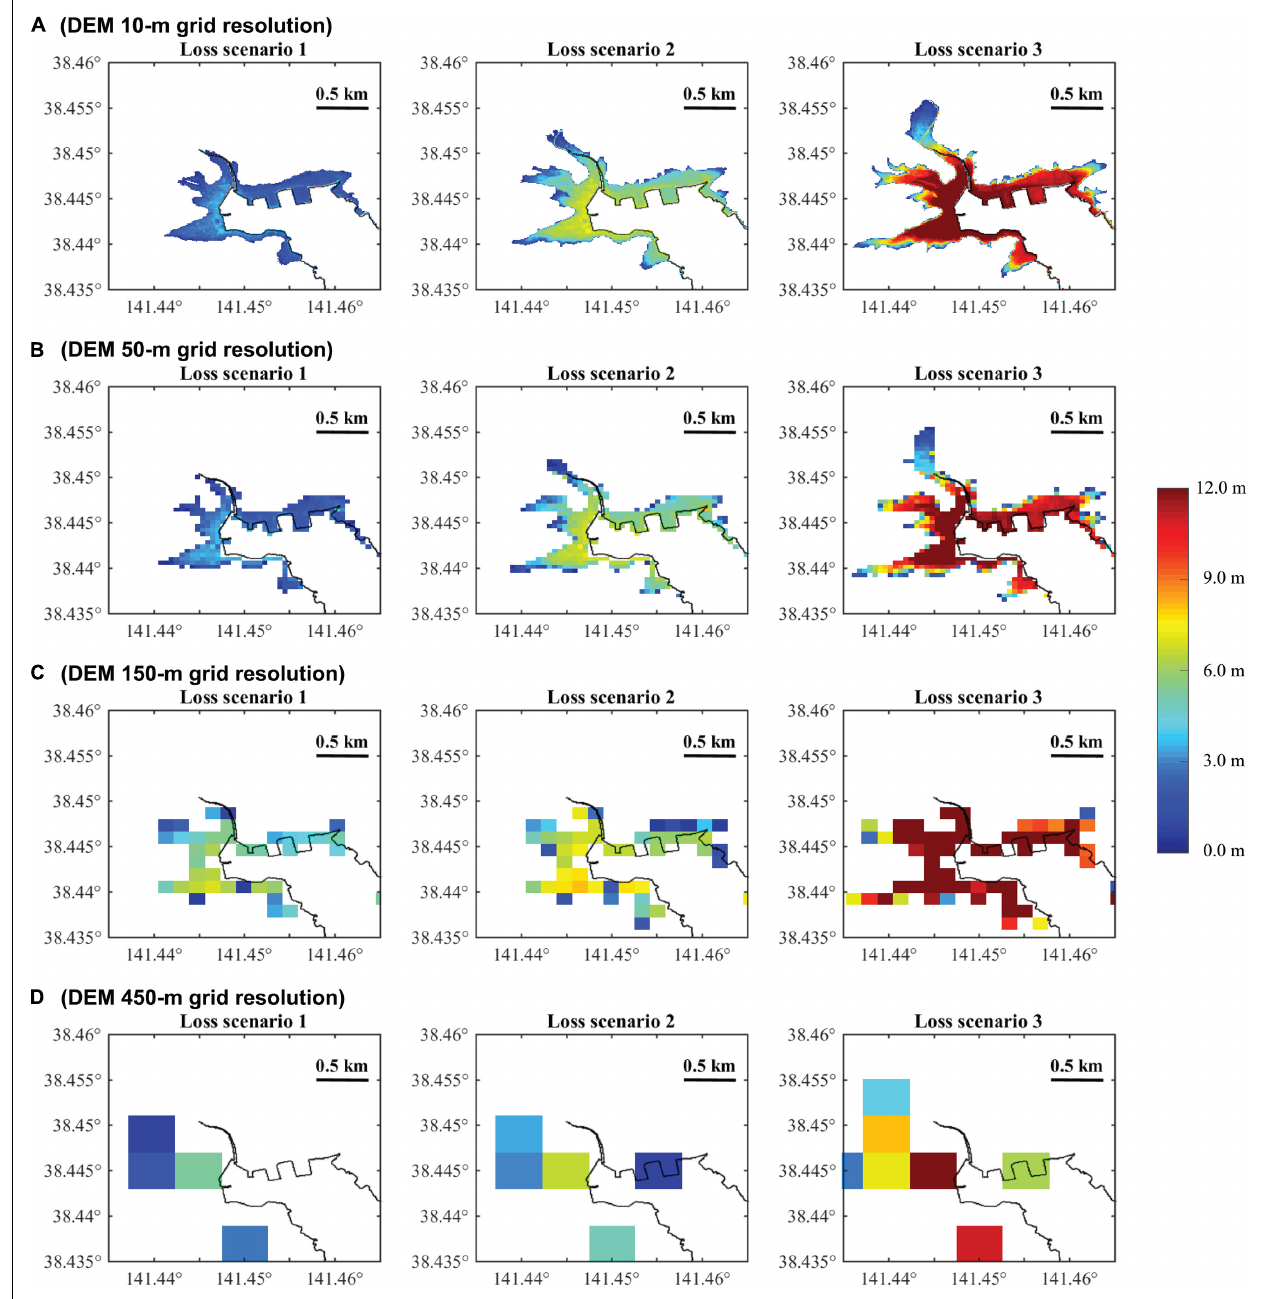
FIGURE 11 | Inundation depth maps of M w 9.0 events for Onagawa by considering different DEM resolutions: (A) 10-m, (B) 50-m, (C) 150-m, and (D) 450-m.